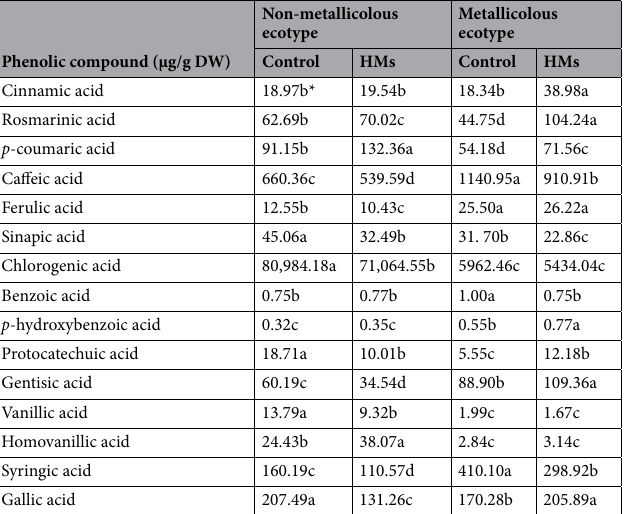
Table 2. Phenolic acids content and composition in shoots of two Alyssum montanum ecotypes cultured on control metal free-medium as well as medium enriched with heavy metals (HMs). *Values are means of three replicates. Means indicated by the same letter do not significantly differ at P < 0.05 according to two-way ANOVA and post hoc Tukey’s test.